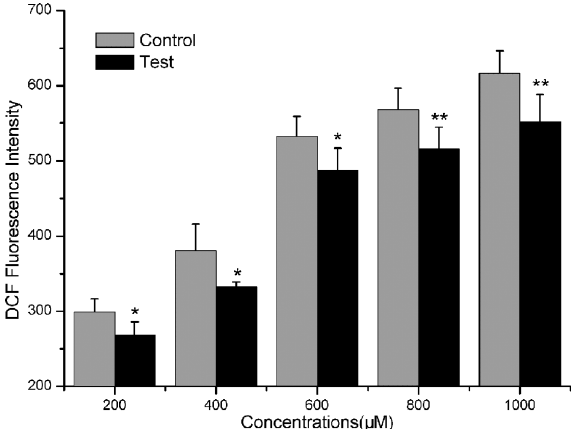
Figure 3. Effects of yeast CUP1 on intracellular ROS. ROS formation, which was determined by fl uorescence intensity, was detected as the measurement of copper stress. Data are reported as means ± SE (n=8). ROS: reactive oxygen species. *P o 0.05, **P o 0.01, compared to control cells ( t